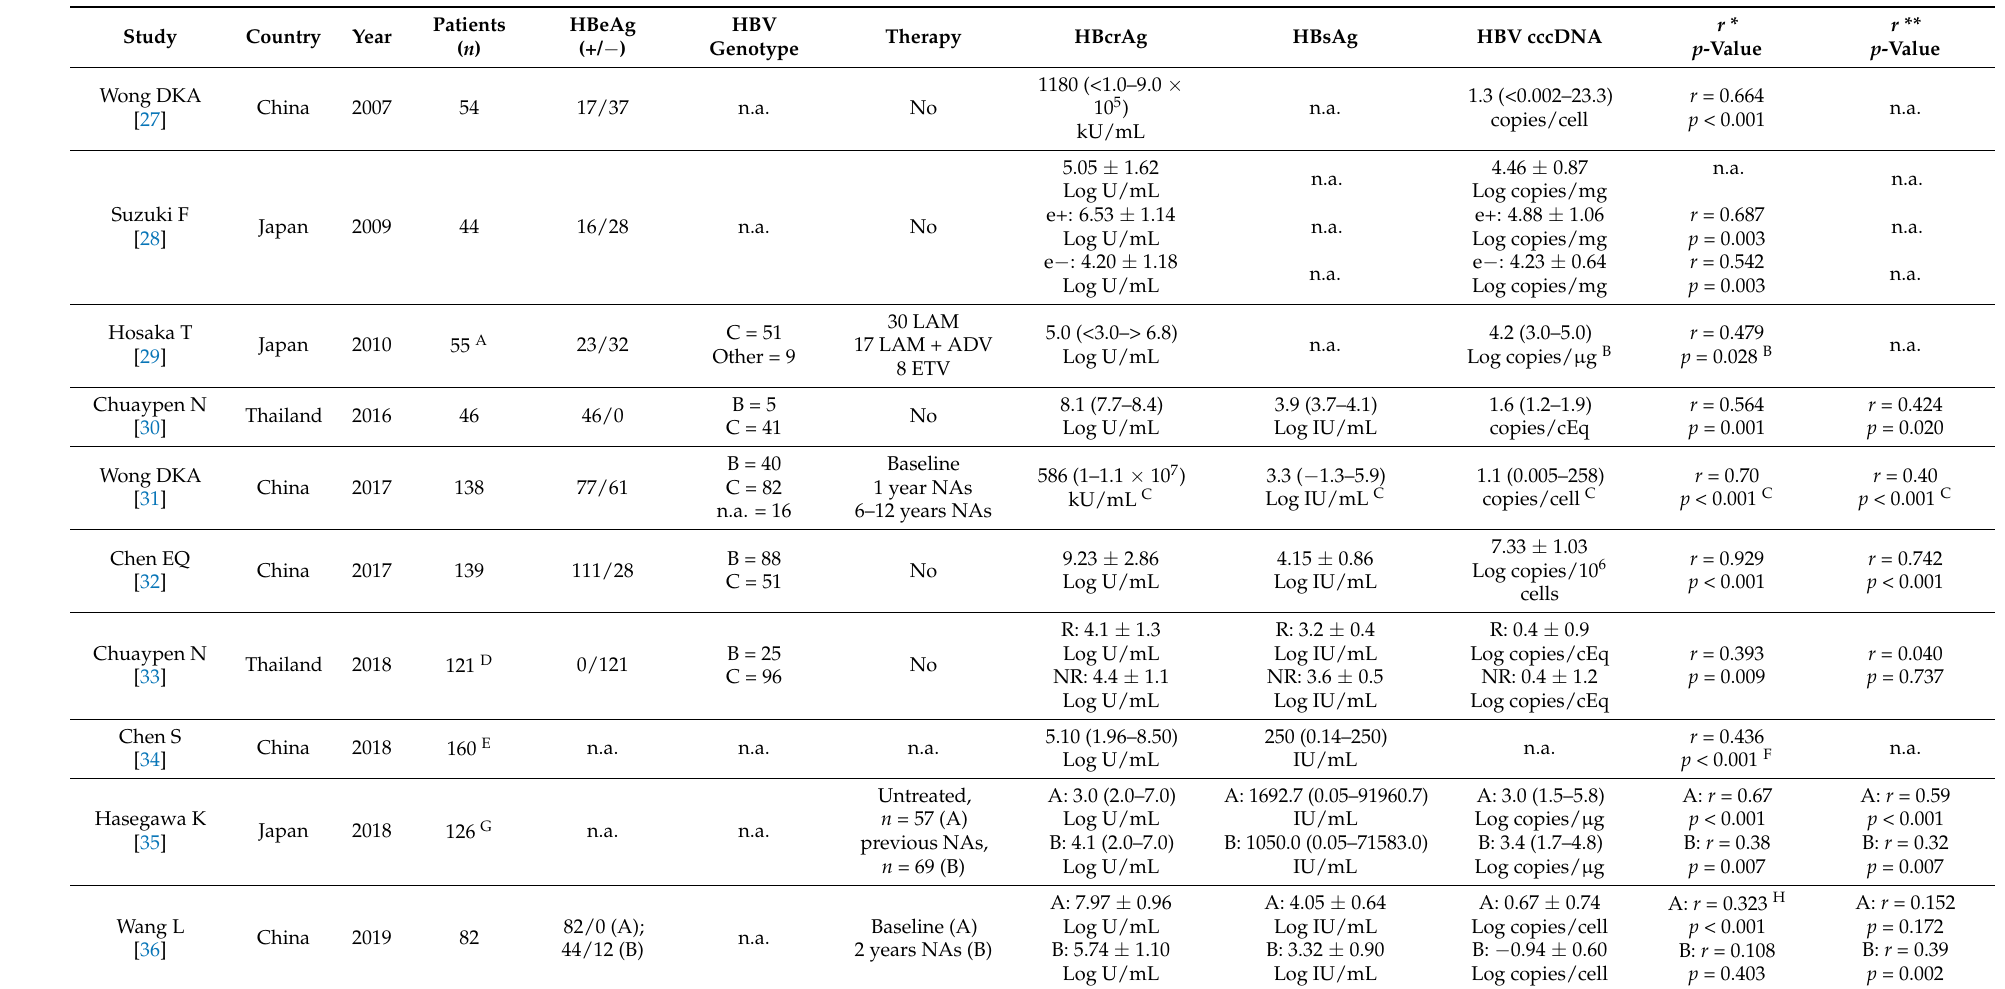
Table 1. Characteristics of the studies included in the